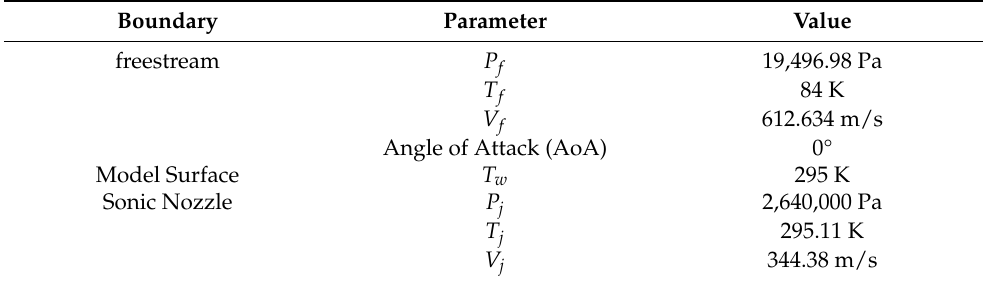
Table 2. Boundary Conditions of the Validation Case.